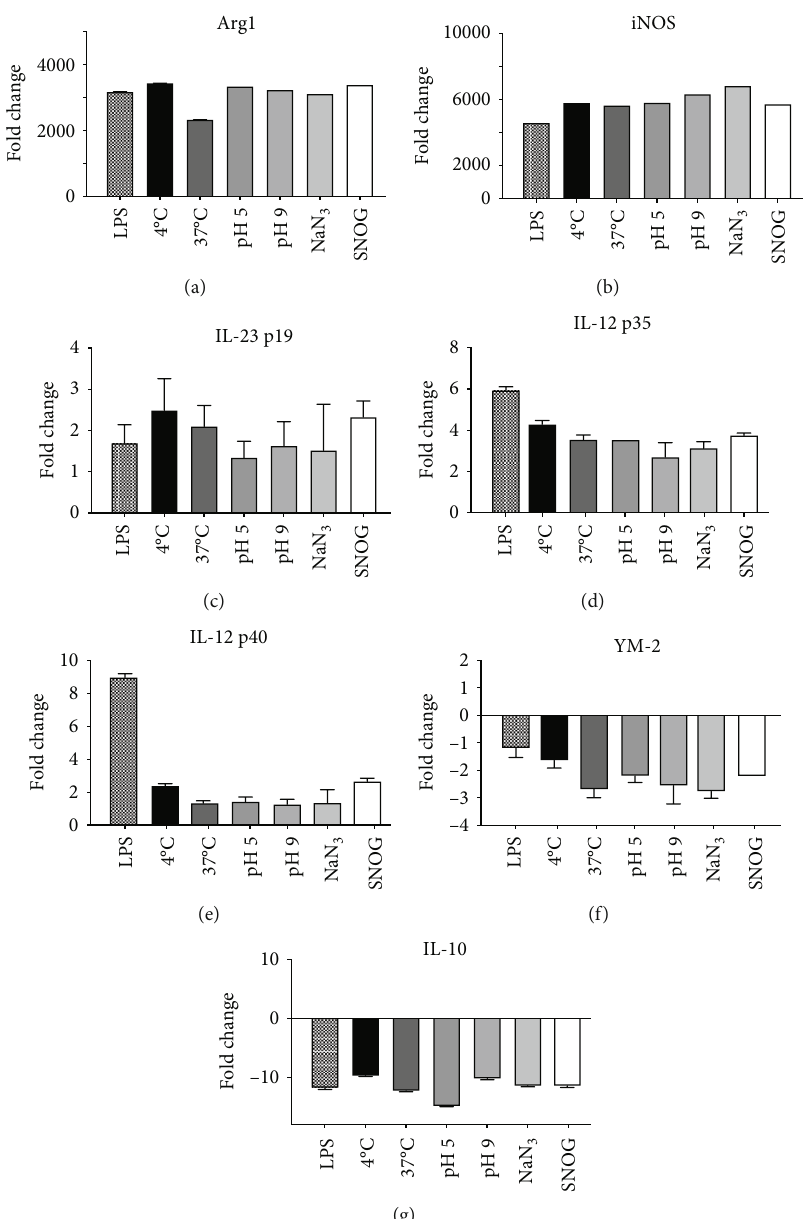
Figure 5: Immunomodulation of EVs obtained from T. cruzi submitted to di ff erent stress conditions. IFN- γ -primed macrophages (BMDM) were incubated (24 h, 37 ° C) with T. cruzi EVs. LPS from E. coli was used as positive control. qRT-PCR was performed to detect the expression of immune response genes: Arg 1 (a), iNOS (b), IL-23 p19 (c), IL-12 p35 (d), IL-12 p40 (e), YM-2 (f), and IL-10 (g) ( n = 3 , ∗ p < 0 : 05